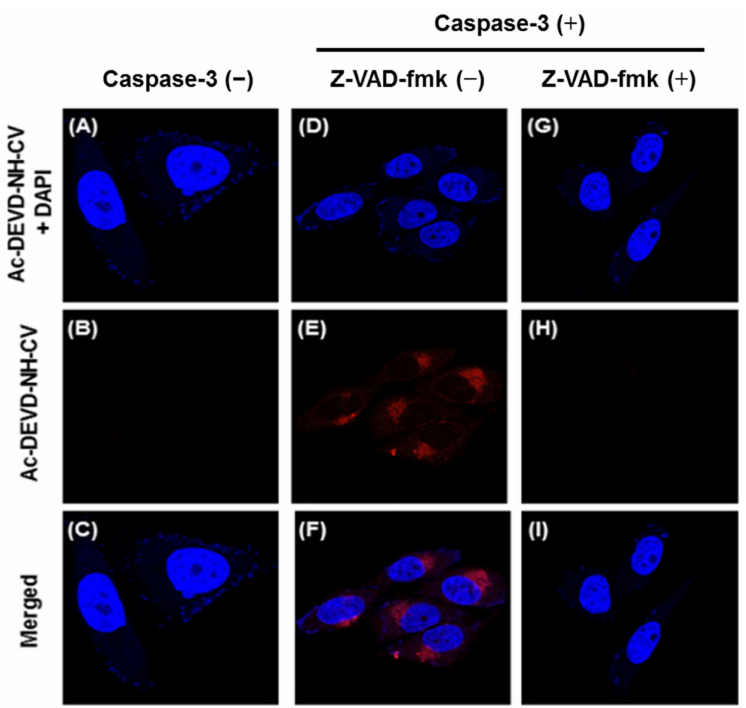
Figure 35. Fluorescent images of HeLa cells incubated with probe 12 (10 µ M) under different conditions. The cells were incubated with probe 12 for 2 h before ( A – C ) and after treatment with caspase-3 in the absence ( D – F ) or in the presence ( G – I ) of caspase-3 inhibitor Z-VAD-fmk (50 nM) for 2 h. The cells were co-stained with the blue fluorescent DNA binding dye DAPI. Top: E x = 405 nm, E m = 410–476 nm; middle: E x = 488 nm, E m = 550–696 nm; bottom: merged images